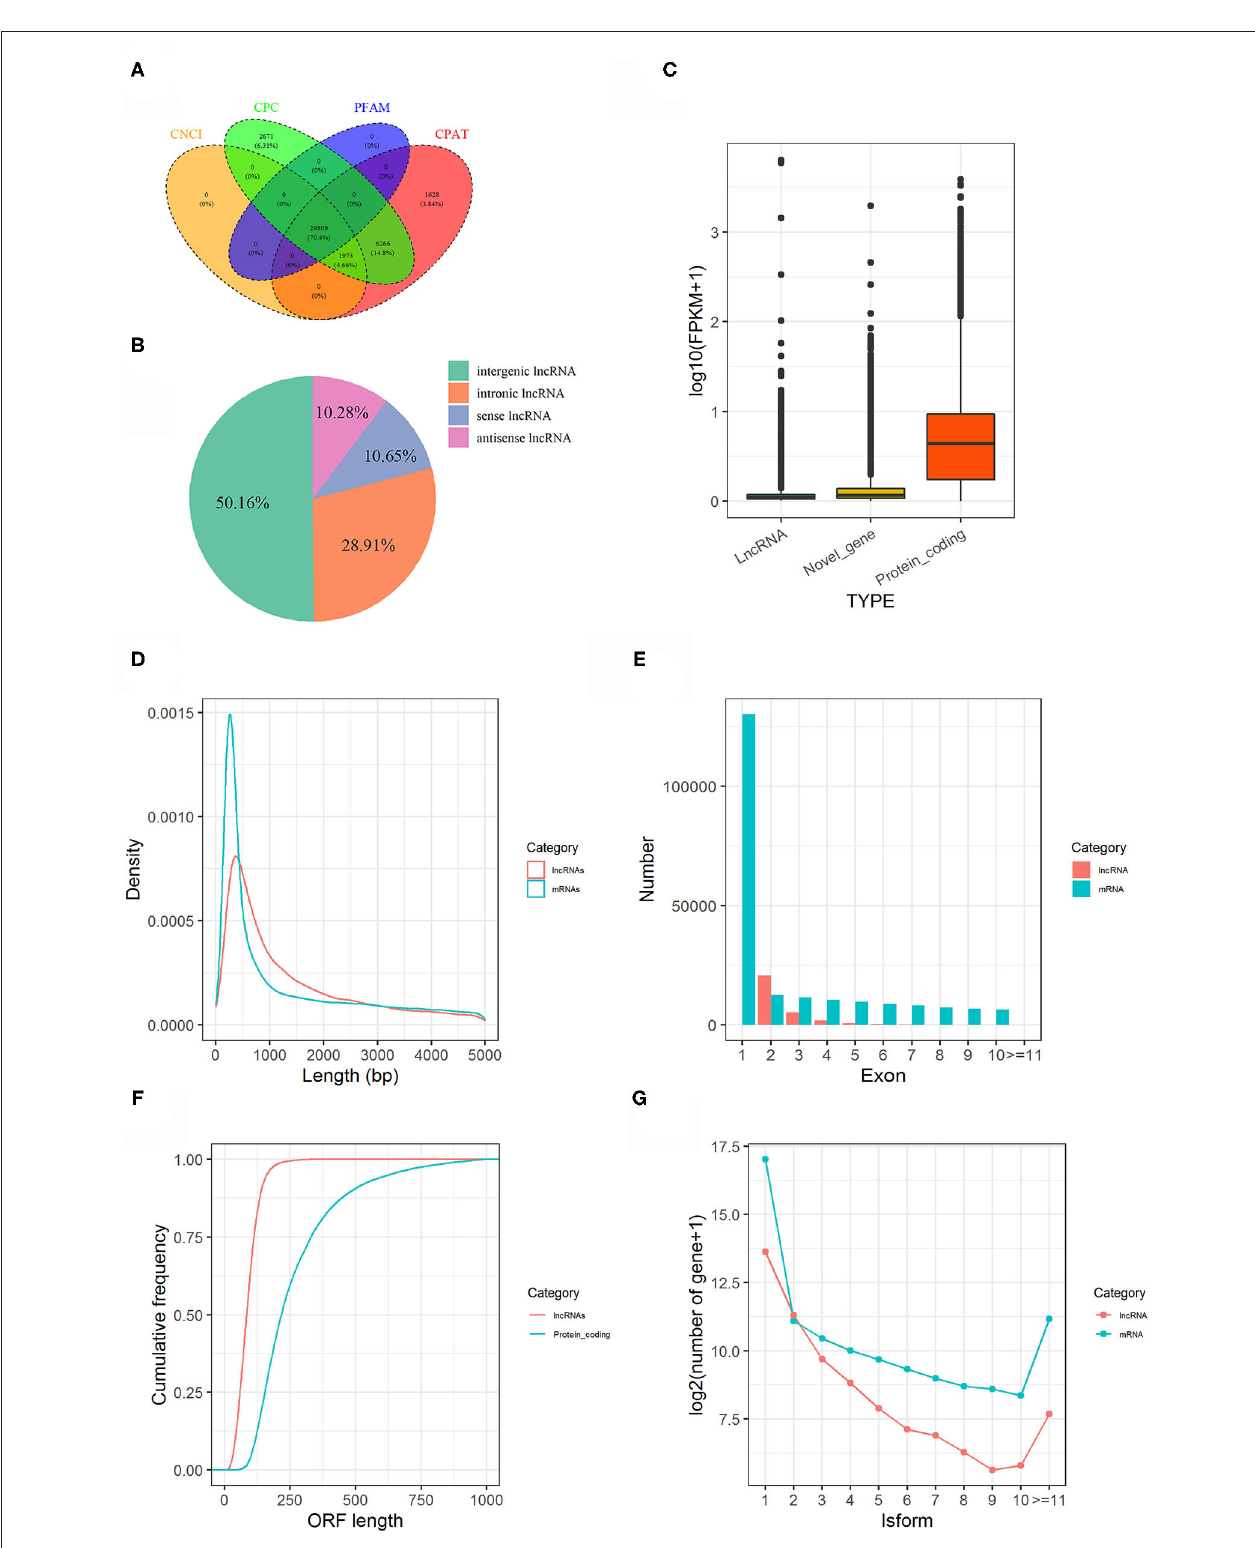
FIGURE 1 | Genome-wide lncRNA prediction and features in pigeon. (A) LncRNAs predicted from CNCI, CPC, CPAT, and PFAM. (B) Classification of predicted lncRNAs. (C) Expression level of lncRNAs, novel genes and protein coding genes. (D) Length distribution of lncRNA transcripts compared to mRNA transcripts. (E) The number of exons for lncRNA transcripts compared to mRNA transcripts. (F) The ORF length of lncRNA transcripts compared to protein-coding genes. (G) Distributions of Alternative splicing of pigeon ( Columba livia ) lncRNAs and mRNAs.